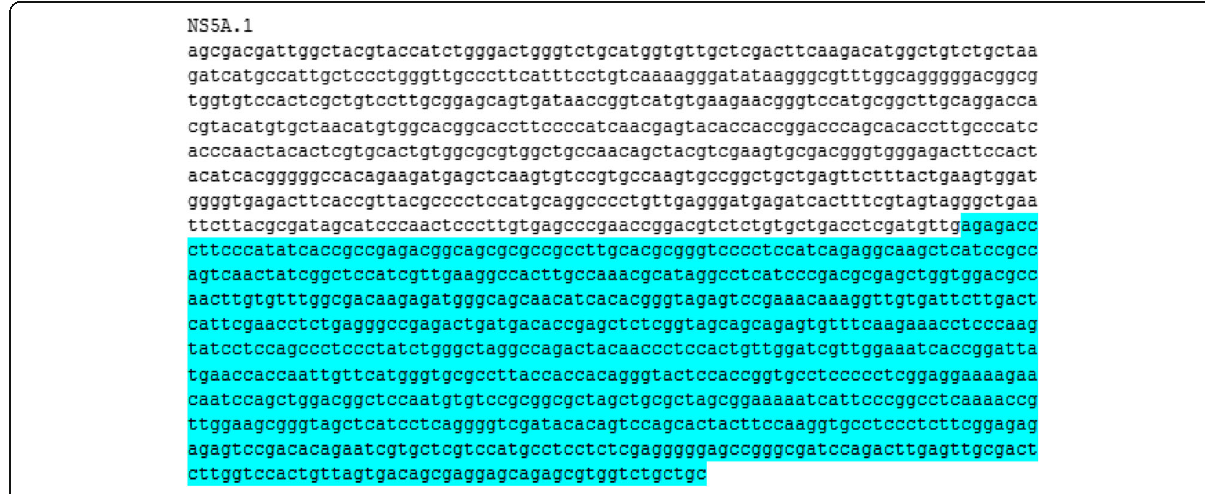
Fig. 2 Full gene sequence of NS5A gene indicating (highlighted) specific antigenic site